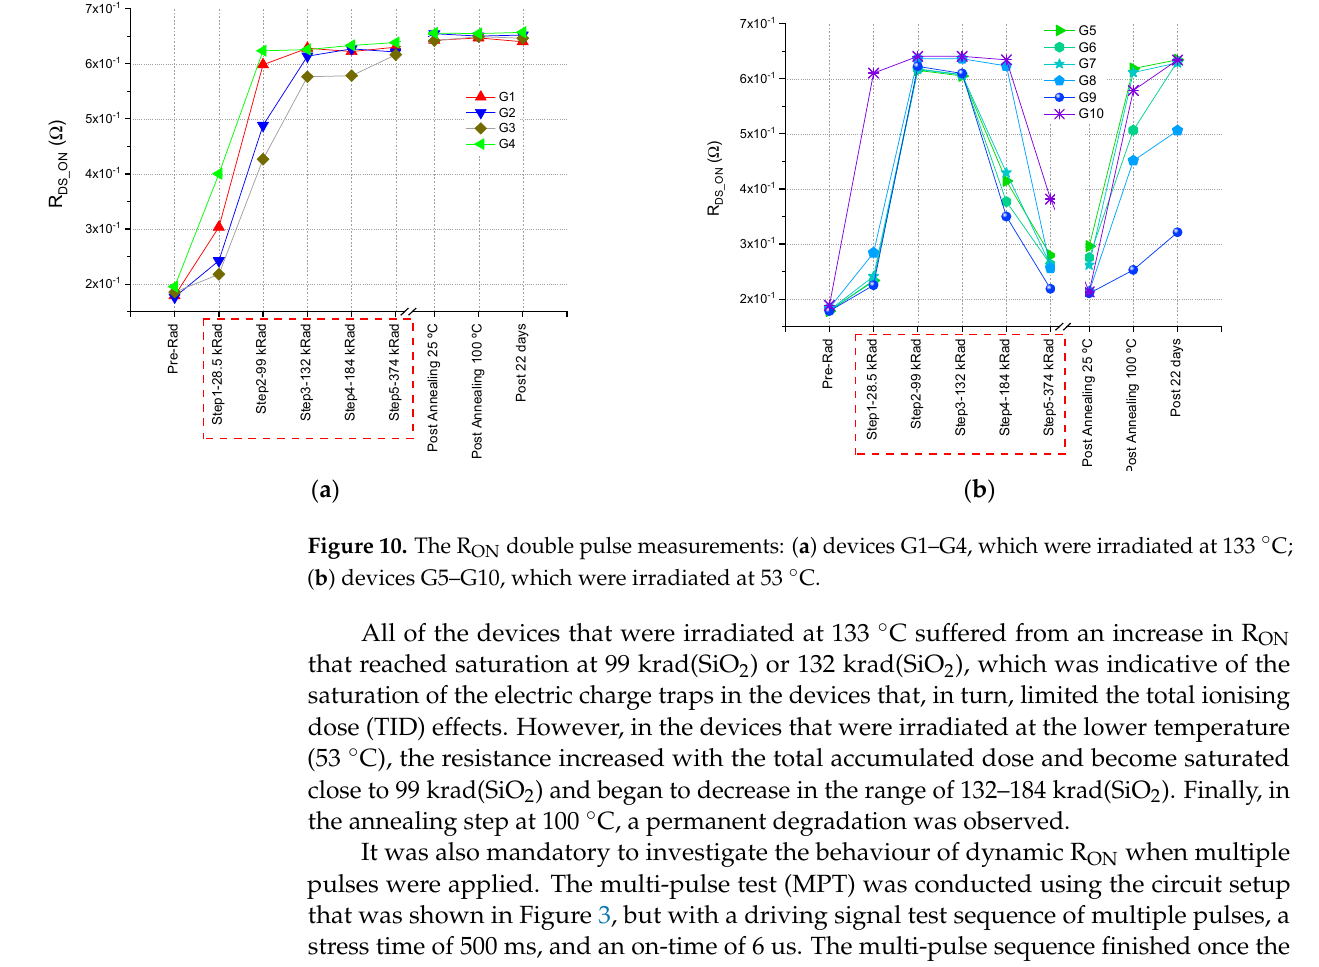
Figure 11. The results of the multi-pulse test for the R ON values of devices G2–G4, which were irra- diated at 133 °C.